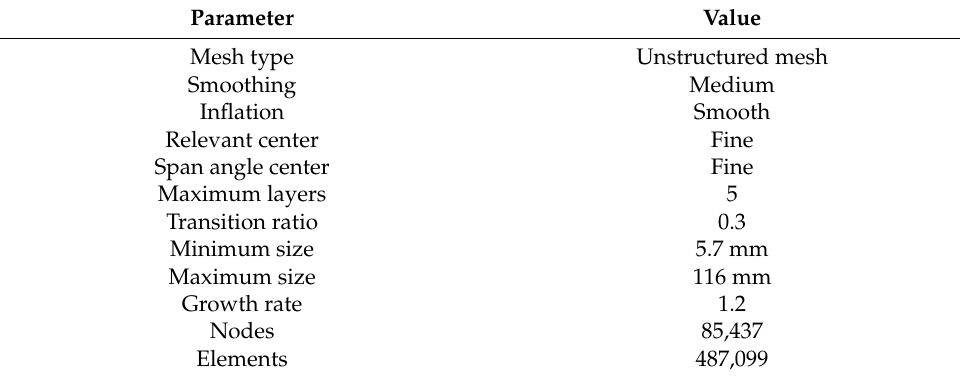
Figure 6. Control volume and wake volume meshed ( left ) and unstructured mesh of the MAV ( right ). ( U ∞ = 10 m/s, α = β = 0 ◦ ). Table 2. Mesh features.